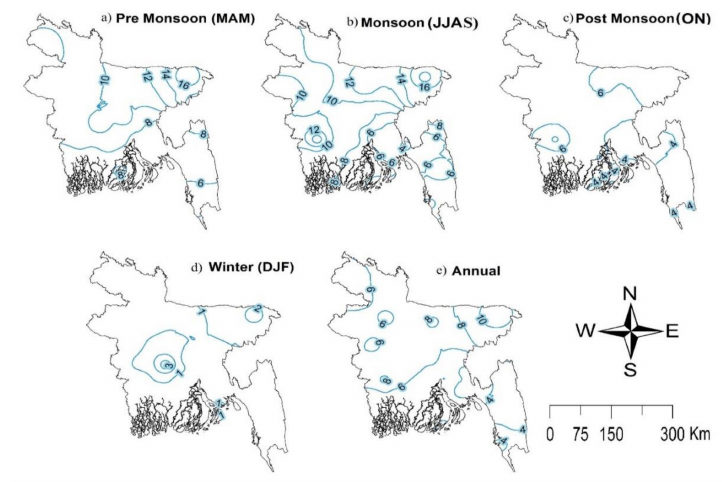
Figure 5. The average number of TS days ( a ) premonsoon (March–May (MAM)); ( b ) monsoon (June–September (JJAS)); ( c ) postmonsoon (October–November (ON)); ( d ) winter (December–February(DJF)); ( e ) annual during 1975–2016 in Bangladesh.